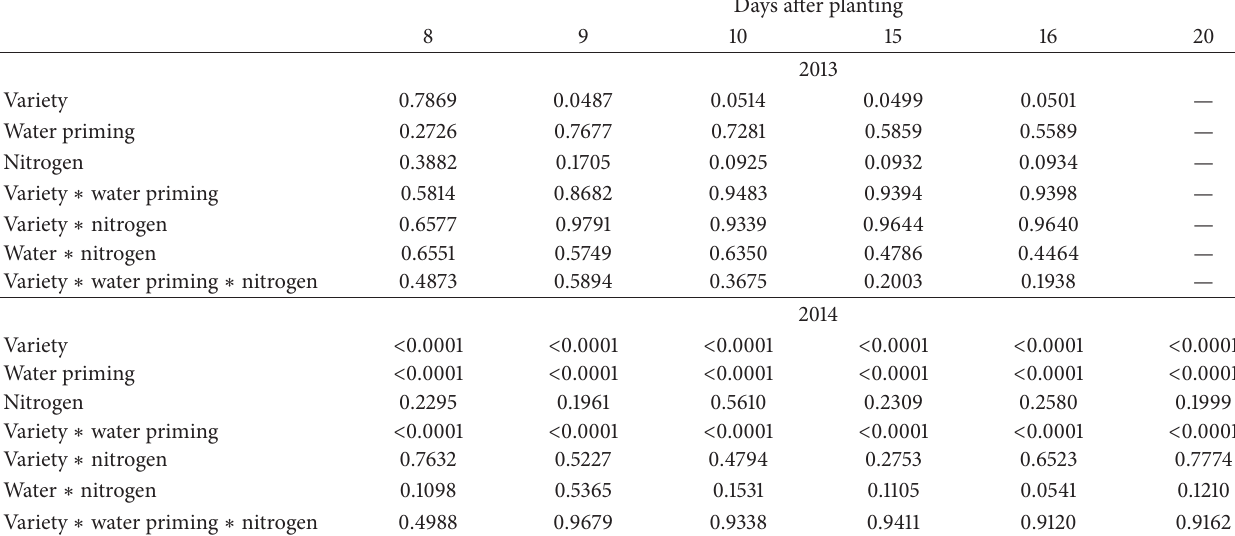
Table 4: Table showing the 𝑃 values for independent variable and their